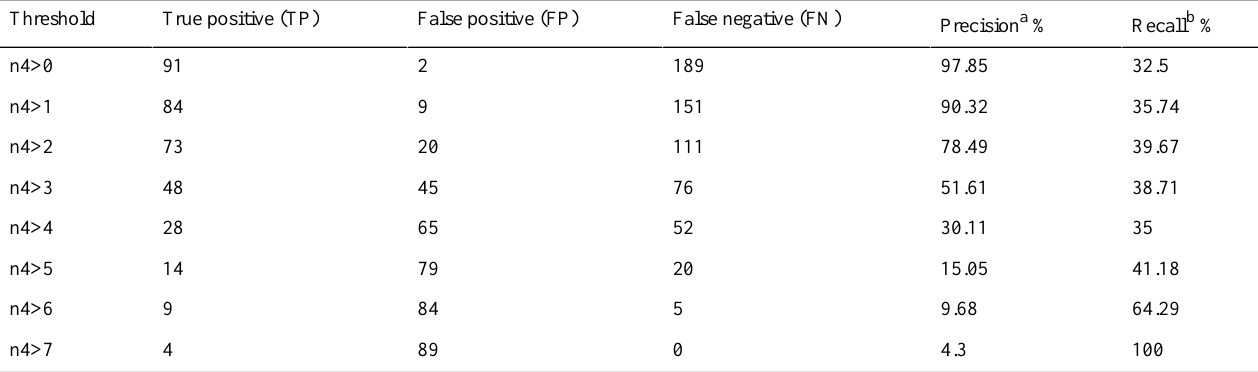
Table 7. Precision and recall for the empirical heuristic developed using Multimedia Appendix 2 (worksheet